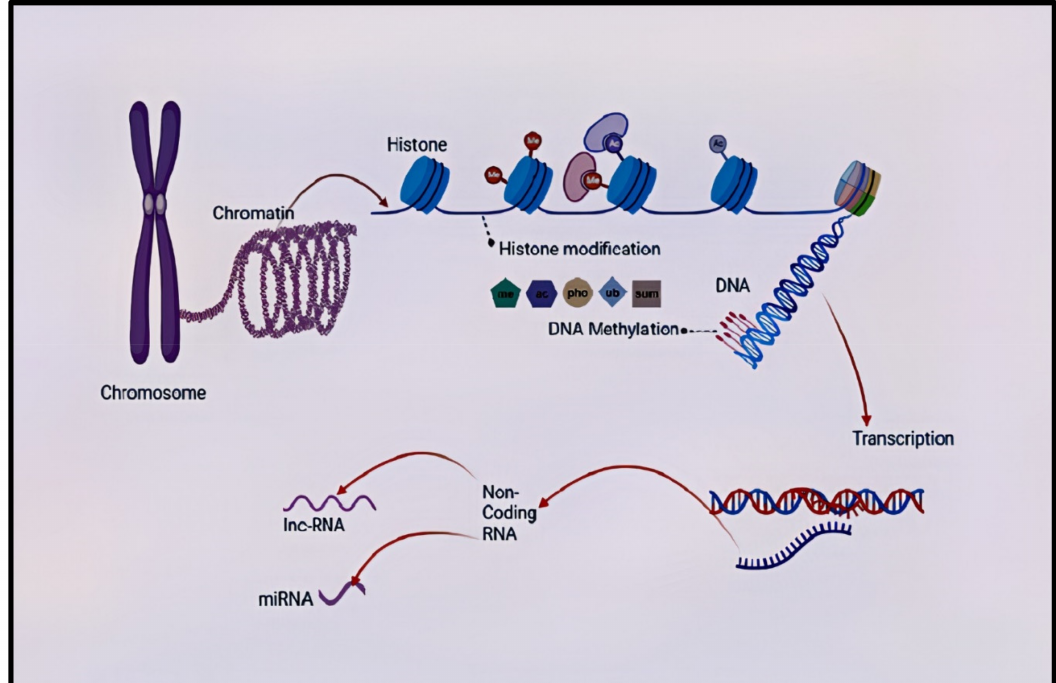
Figure 1. Summary of epigenetic processes that can occur in the mammalian central nervous system. The DNA–protein complex in chromosomes is called a chromatin, who’s functional is a nucleosome (not shown). There is the transcriptionally accessible (found in loosely coiled chromatins) and inaccessible (found in tightly coiled chromatins) DNA. DNA interacts with the N terminal tails of the histone and this gives sites for histone modifications. Histone modification process is a covalent post-translational modification of the histone proteins, and it includes histone methylation (me), acetylation (ac), phosphorylation (pho), ubiquitination (ub), and SUMOylation (sum). Another level of epigenetic regulation is non- coding RNA. DNA methylation occurs when the methyl groups attach covalently to the cyto-sine-guanine dyads (CpG) dinucleotide and non-CpG regions of the DNA. The transcription process makes an RNA copy like mRNA (not shown) from the DNA sequence. Non-coding RNAs can be categorised into long non-coding RNAs and small non-coding RNAs (micro-RNAs). They are involved in chromatin and nuclear remodelling, gene transcription, translational repression, and degradation of messenger RNAs. DNA—deoxyribonucleic acid, RNA—ribonucleic acid, me—methylation, ac—acetylation, pho—phosphorylation, ub—ubiquitination, sum—SUMOylation, miRNA—micro RNA, lnc-RNA—long non-coding